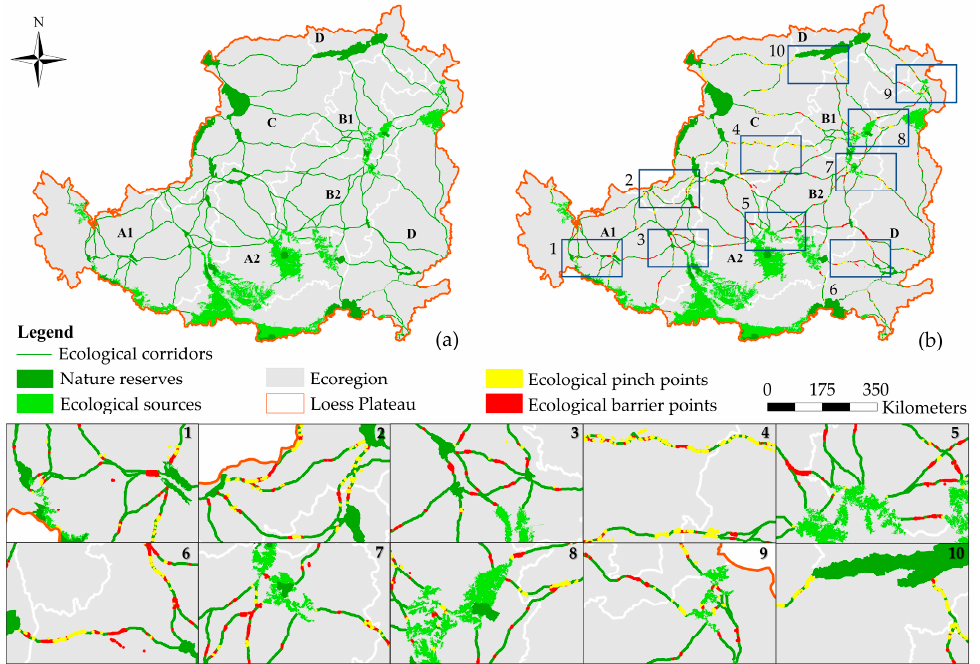
Figure 8. Spatial distribution of ecological security patterns (ESPs) on the Loess Plateau. ( a ) shows the whole ESPs of the Loess Plateau, and ( b ) shows the location diagram of local ESPs of the Loess Plateau.